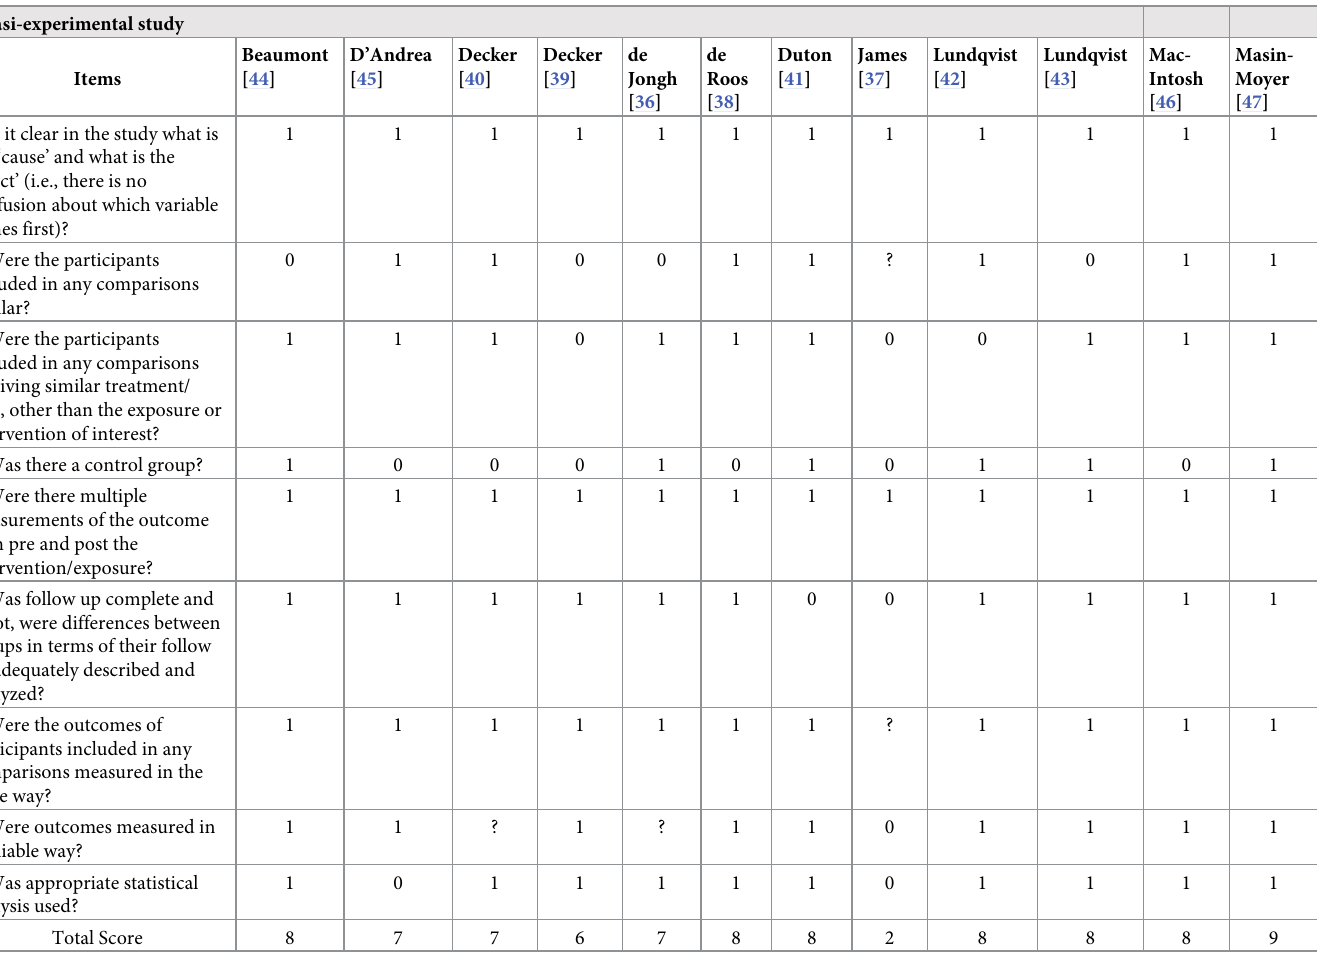
Table 3. Study quality ratings for quasi-experimental